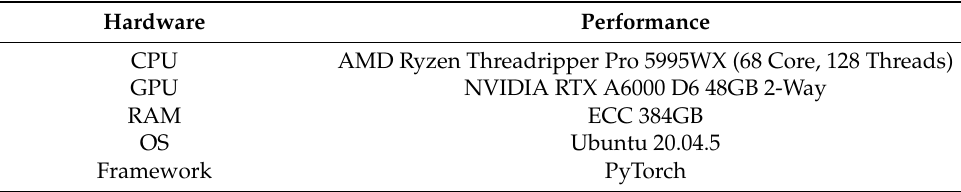
Table 4. Device environment for training.